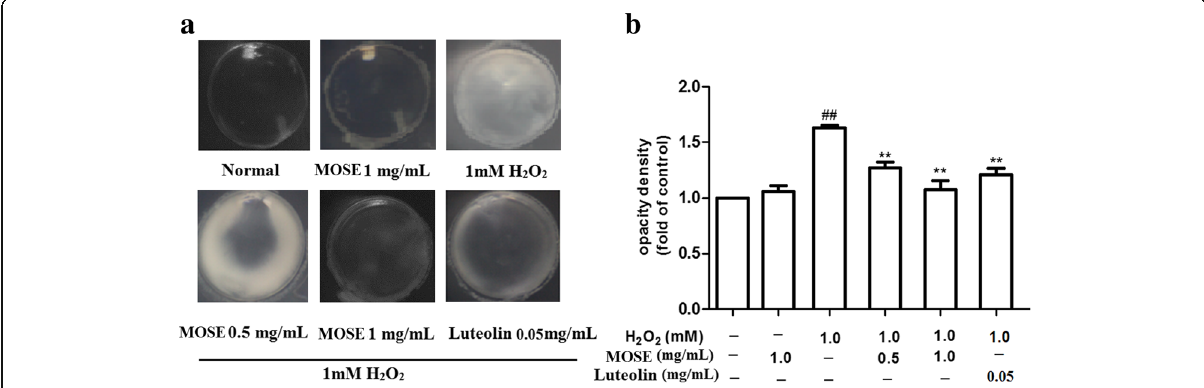
Fig. 2 Effects of MOSE and luteolin on lens opacity in H 2 O 2 -induced cataract. Lenses were pretreated with MOSE (0.5 and 1.0 mg/mL) or luteolin (0.05 and 0.1 mg/mL) for 24 h, followed by incubation with H 2 O 2 (1 mM) for another 24 h and then recovered in fresh medium for 48 h. a Representative photograph showing the lens with different treatment. b Quantificaton of lens opacity density. Data are expressed as the mean ± SEM ( n = 6); ## P < 0.01, compared with the normal control group; **P < 0.01 compared with the H 2 O 2 treatment